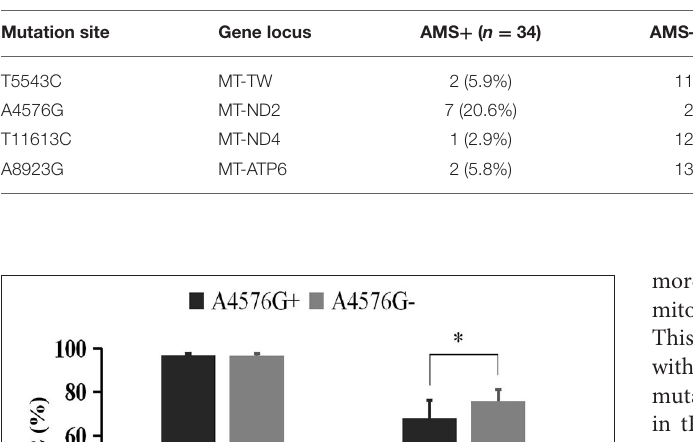
TABLE 10 | Logistic regression analysis of mitochondrial gene mutation.